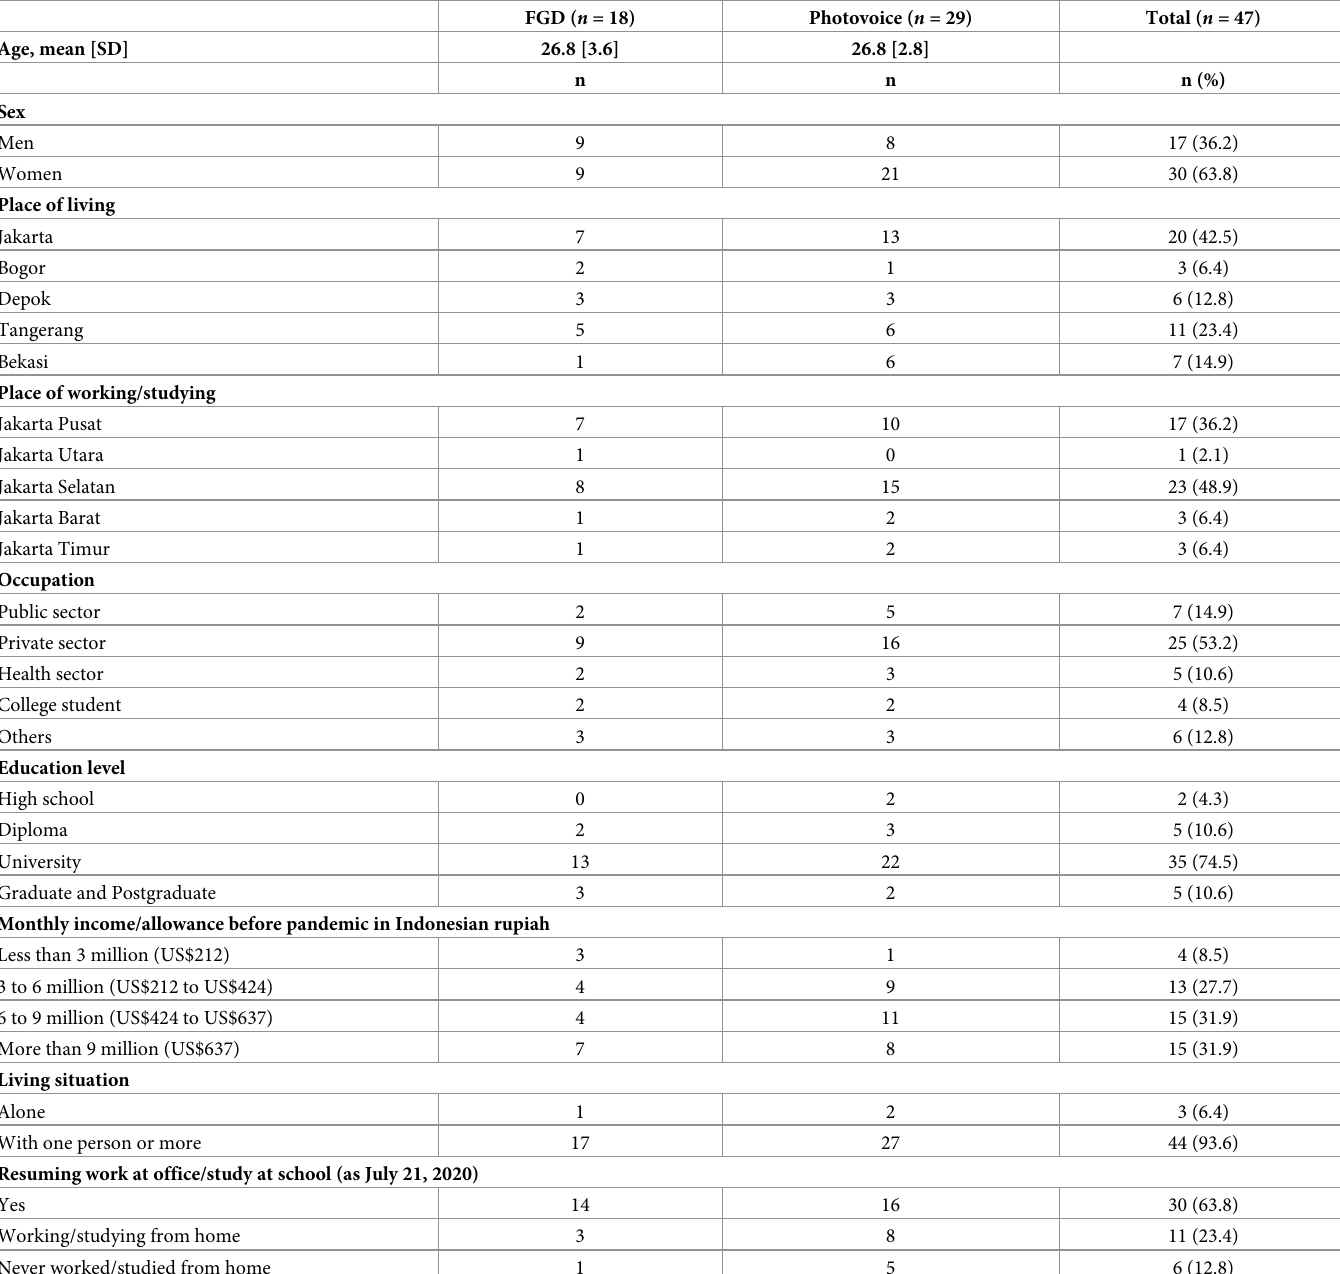
Table 3. Sociodemographic characteristics of young adults in the qualitative phase ( n =